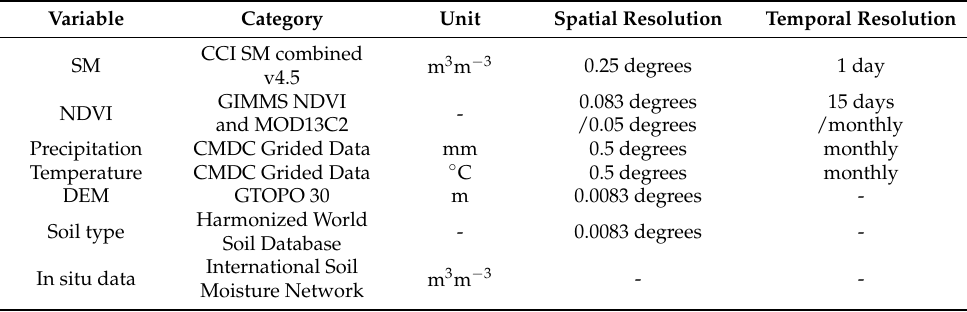
Table 1. Characters of the SM and ancillary dataset used in the study.